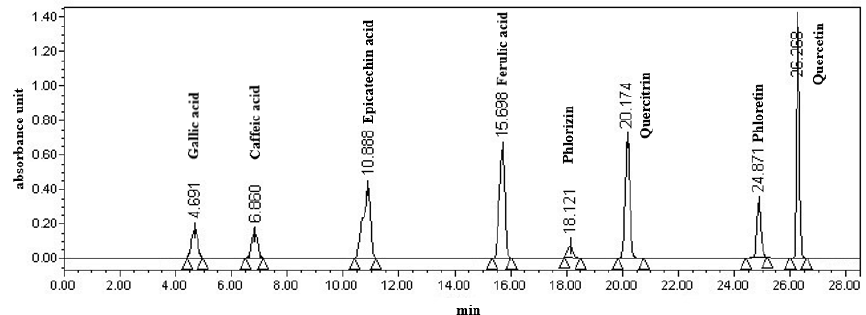
Figure 1. Chromatogram of 8 polyphenols detected with HPLC at 280 nm.